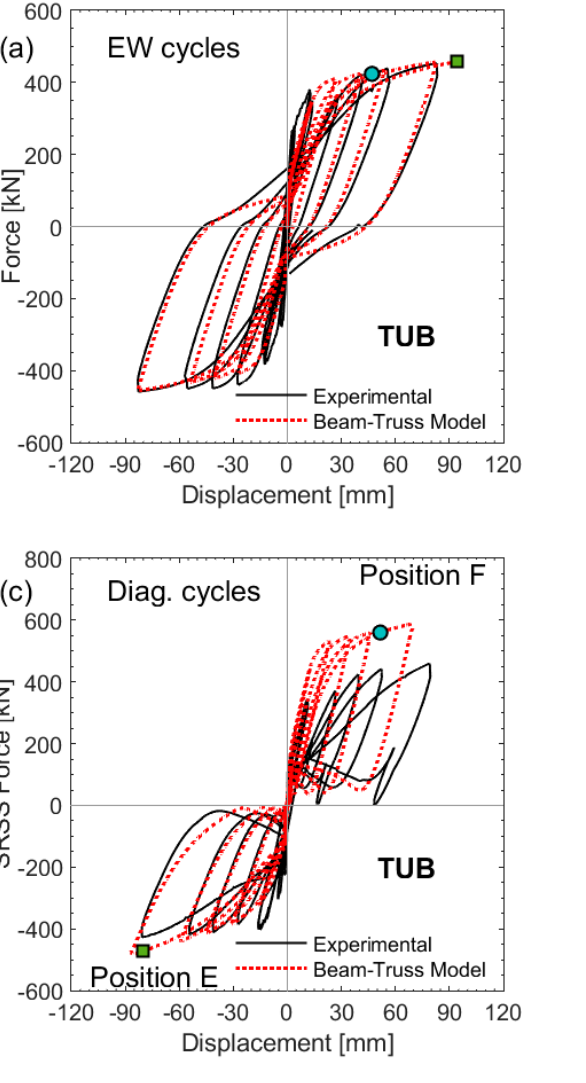
Figure 5. Beam-truss model results using SeismoStruct compared to the experimental results for wall unit TUB [19] for ( a ) east–west cycles, position A–B ( b ) north–south cycles, position C–D, ( c ) diagonal cycles, position E–F, and ( d ) restraining torsional moment. The cross, circle, and square markers indicate the numerically estimated concrete crushing, rebar buckling, and rebar fracture, respectively, corresponding to the defined strain limits.